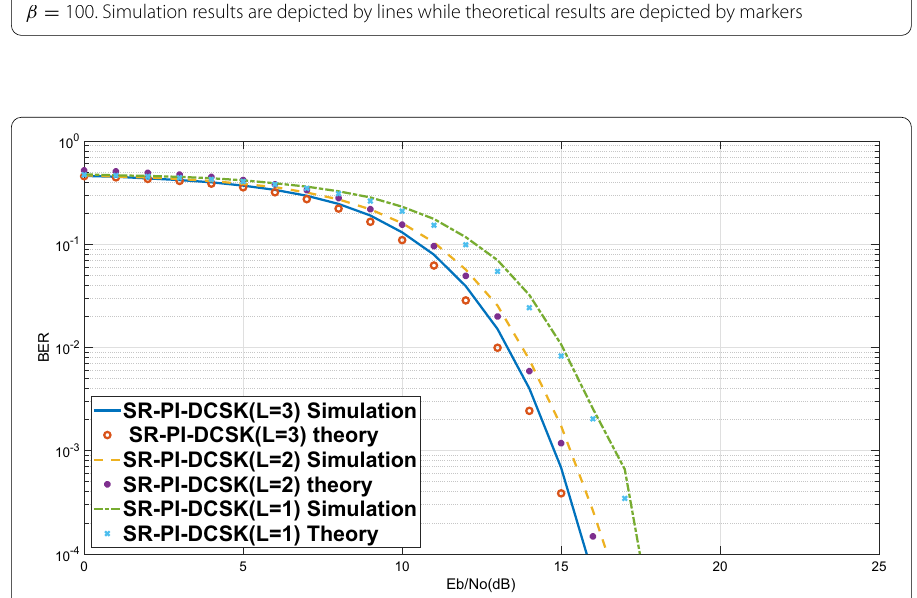
Fig. 13 Theoretical and simulation bit error performance for SR‑PI‑DCSK for different frame lengths for β = 150 . Simulation results are depicted by lines while theoretical results are depicted by